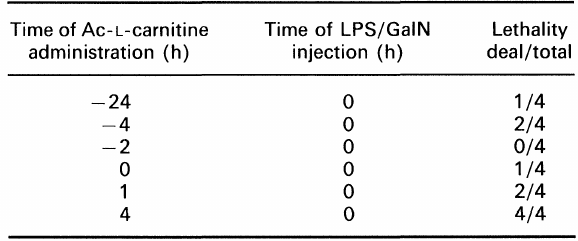
Table 10. Effect of time of acetyI-L-carnitine injection on the lethal activity of LPS/GalN in mice